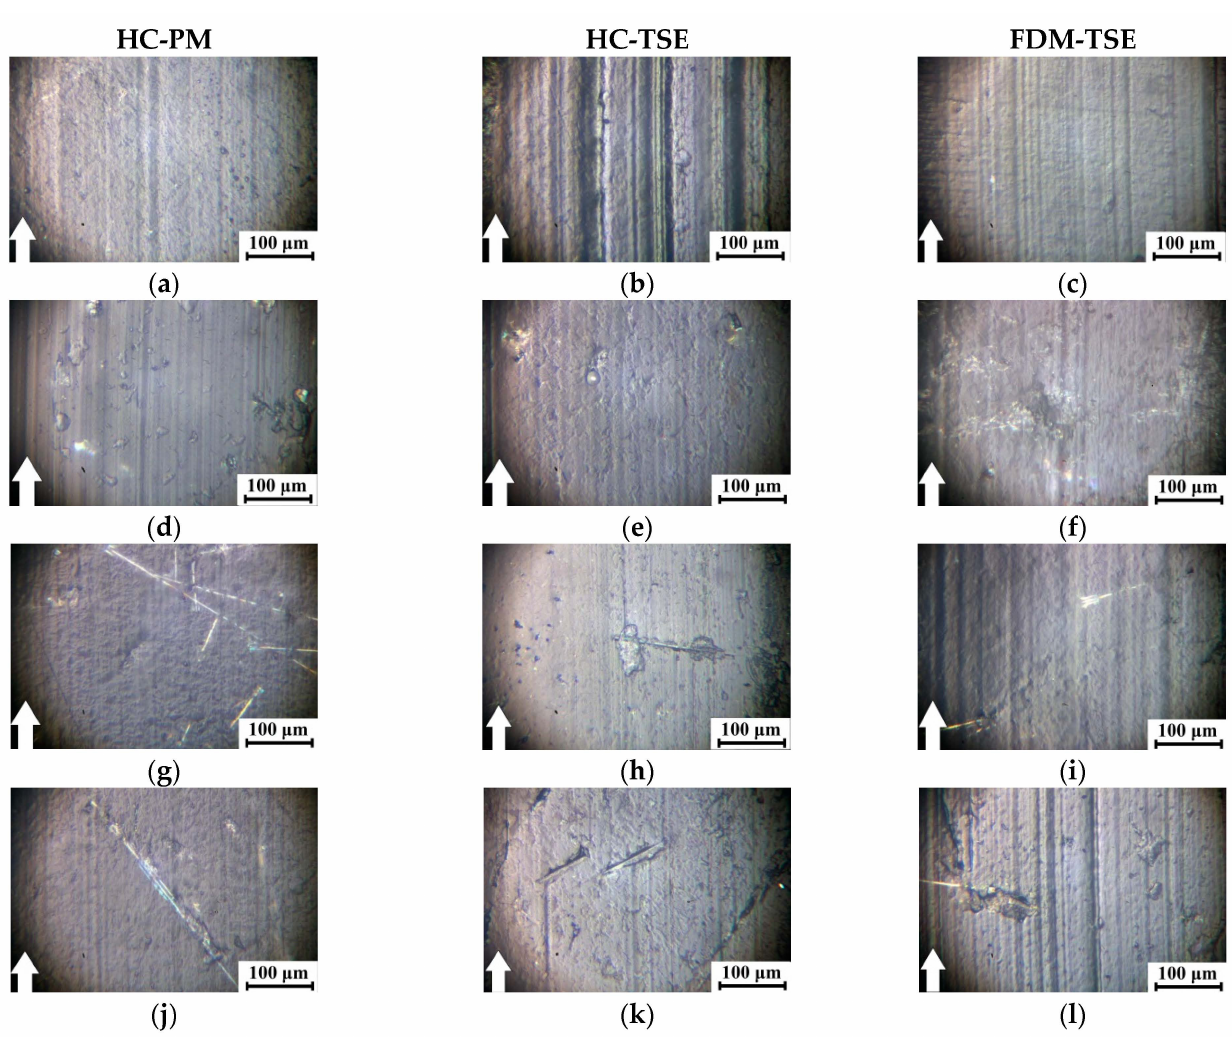
Figure 10. The wear track surfaces on the ‘UHMWPE+17%HDPE-g-VTMS+12%PP’ sample ( a – c ) and the composites ( d – l ) fabricated by the HC-PM, HC-TSE, and FDM-TSE methods: ‘UHMWPE+17%HDPE-g-VTMS+12%PP+5%HGS’ ( d – f ); ‘UHMWPE+17%HDPE-g-VTMS+12%PP+5%MGF’ ( g – i ); ‘UHMWPE+17%HDPE-g-VTMS+12%PP+5%CGF’ ( j – l ). 60 N · 0.3